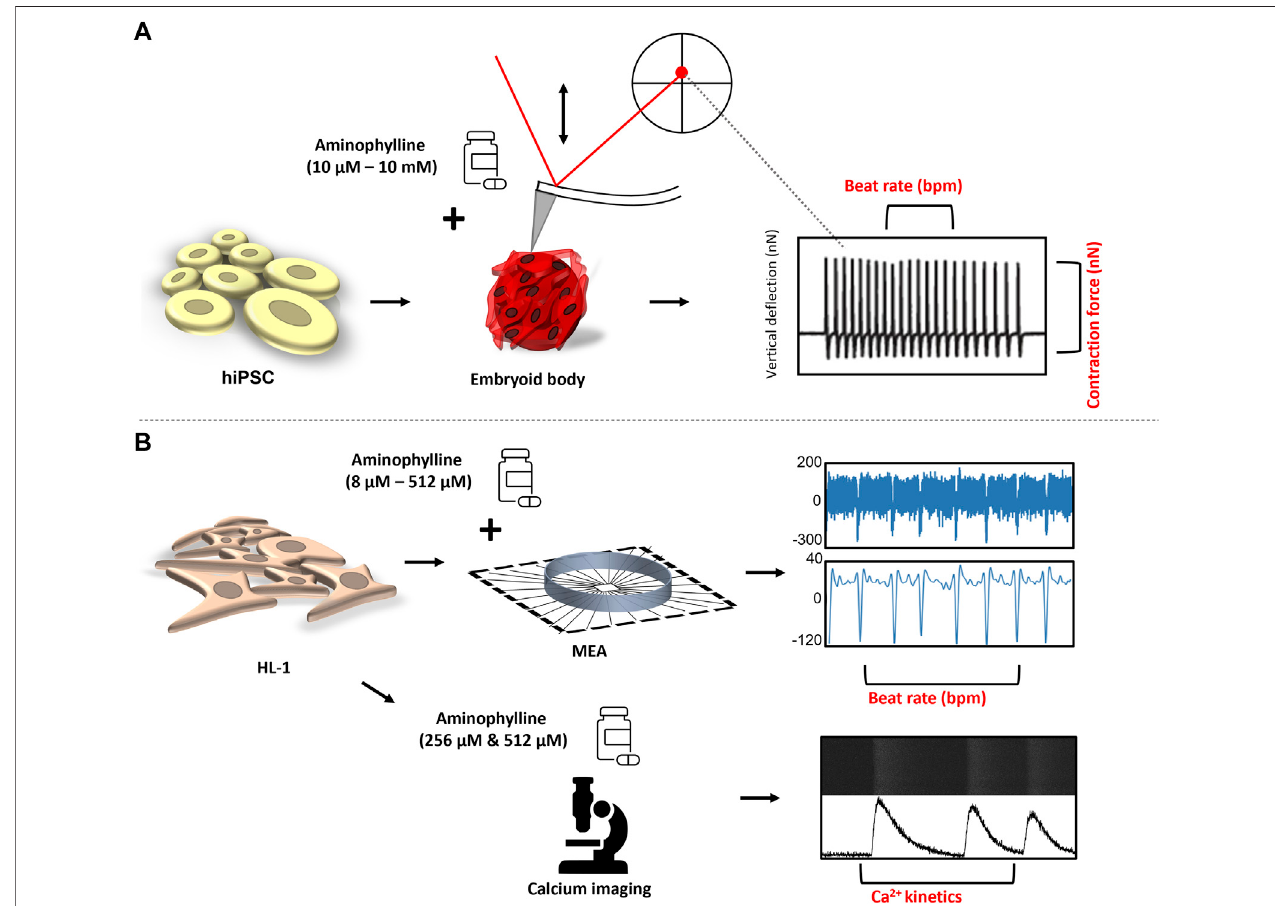
FIGURE 1 | Experimental design: (A) hPSCs were differentiated in the form of EBs into contracting 3D clusters of cardiomyocytes, and under the in fl uence of increasing concentrations of aminophylline, the mechanocardiogram (MCG) was recorded was recorded by an atomic force microscope. The BR and contraction force valuesofeachcontractiveeventwerefurtheranalyzedandcompared. (B) Fieldpotentialbythemultielectrodearray(MEA)system,togetherwithintrinsicCa 2+ kineticsvia Fluo-8 AM, a calcium-binding dye, was assessed on HL-1 cells to further con fi rm the arrhythmogenic effect of aminophylline.